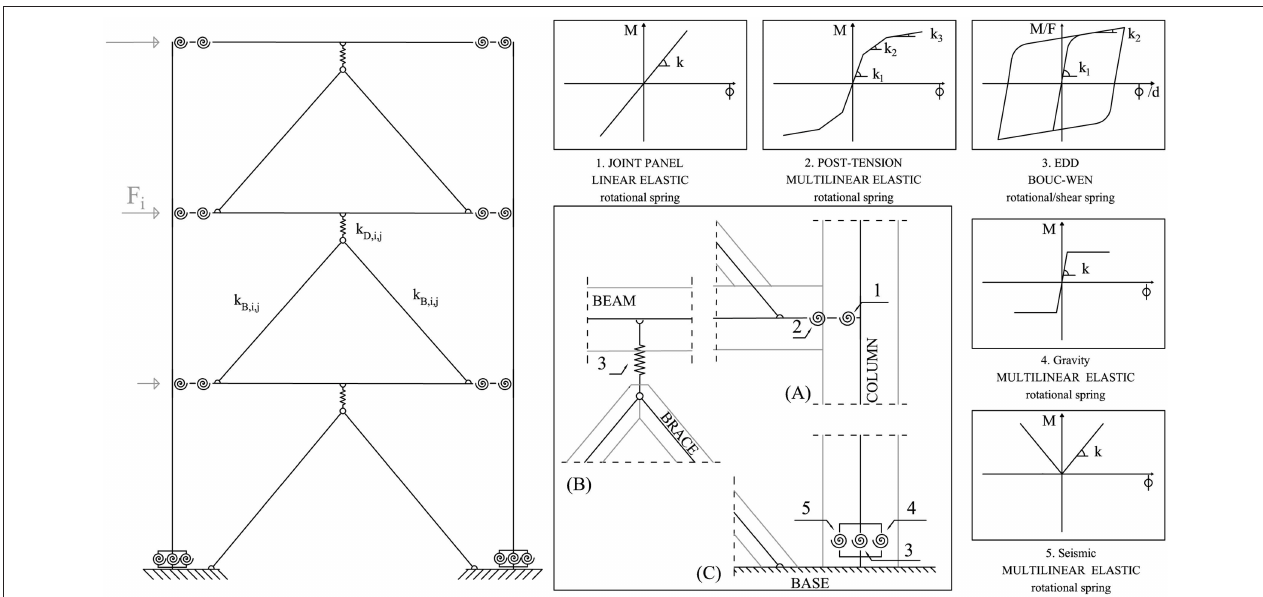
FIGURE 6 | Numerical modeling of the braced post-tensioned frame and details adopted for rocking connections (beam-column and column-foundation) and for dissipative bracing systems.